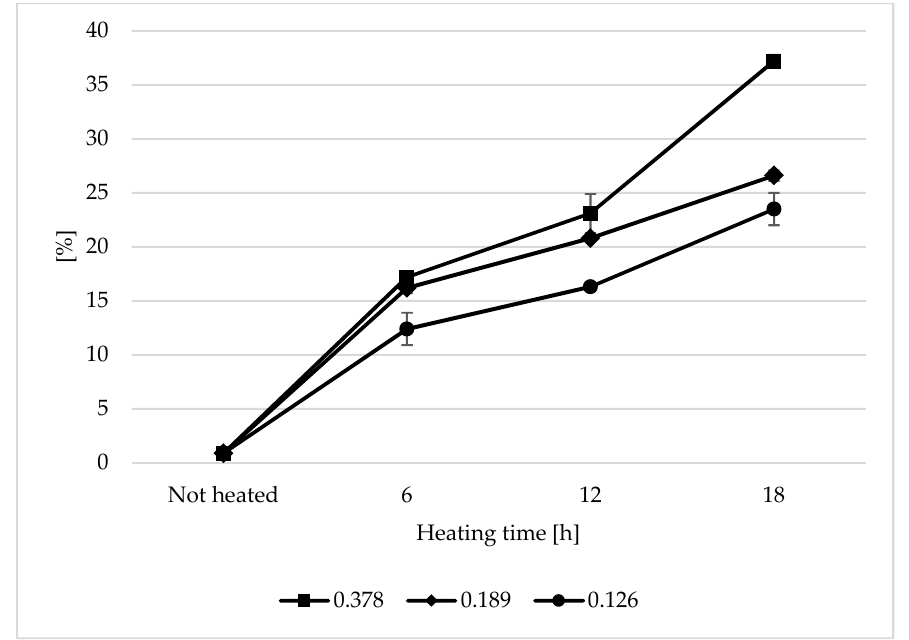
Figure 1. Changes in total polar compounds (TPC) during thermal treatment of refined (RRO) rapeseed oil with different surface-to-volume of oil ratios [%]. Table 1. Fatty acid composition [%], iodine value (CIV), and total chromanol content [mg/100 g] in refined rapeseed oil heated at 170 ◦ C with different surface-to-volume (s/v) ratios.